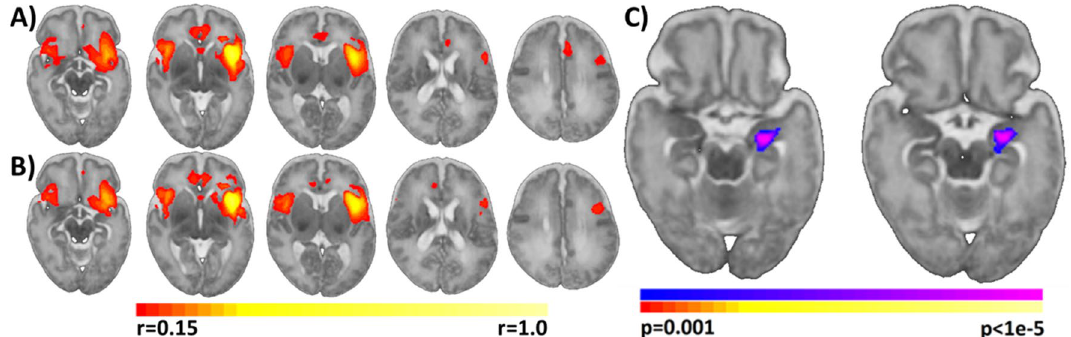
Figure 1. Left anterior insula (aINS) connectivity in neonates with high and low genetic likelihood for developing autism. ( A ) aINS connectivity for the LL group. ( B ) aINS connectivity for the HL group. ( C ) Comparison of aINS connectivity between LL and HL neonates. Overall, the HL group had significant weaker connectivity between the left aINS and the left amygdala compared to the LL group (p < 0.05, corrected). Slices are shown in radiological